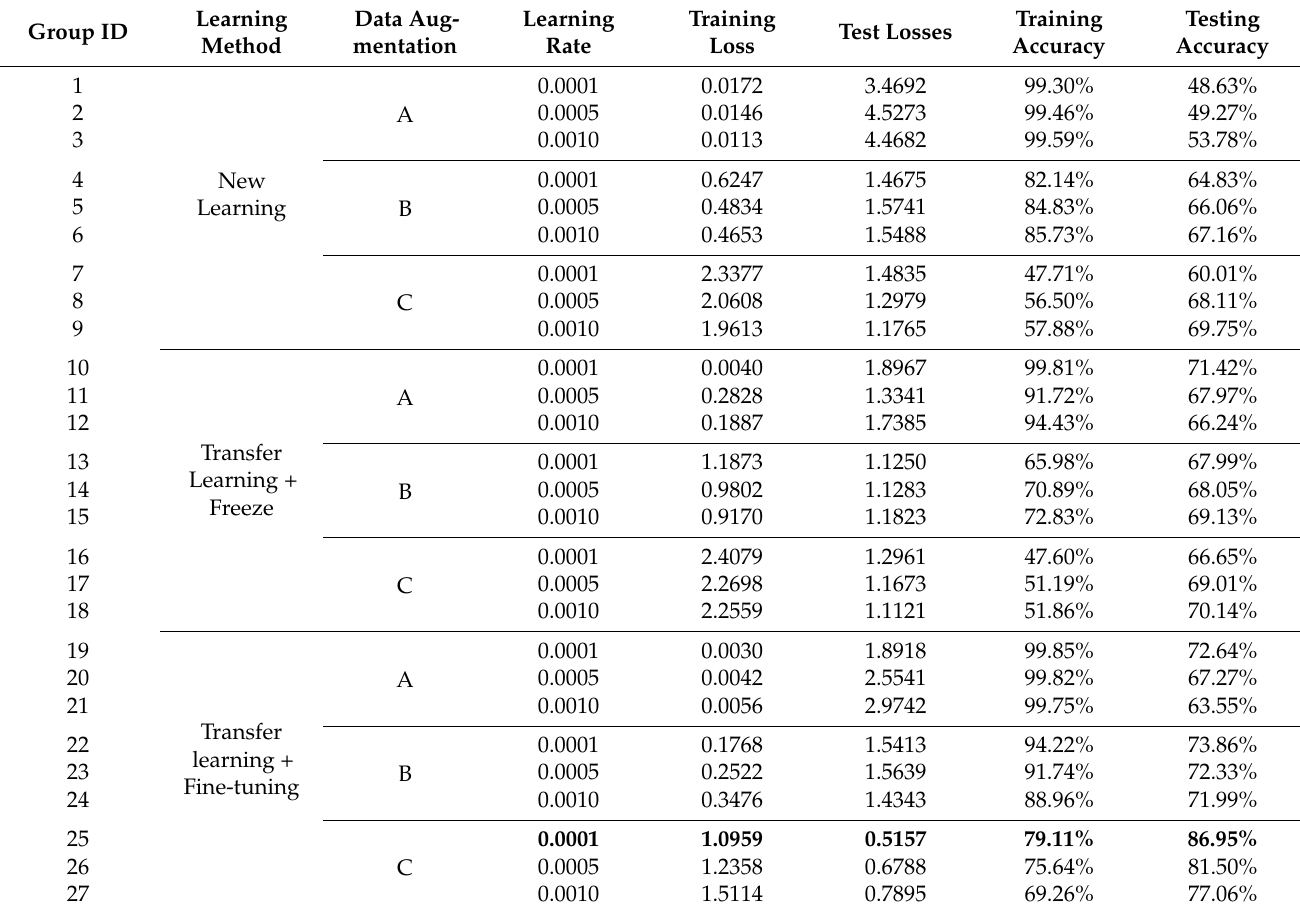
Table 2. Loss and accuracy of model training and test.